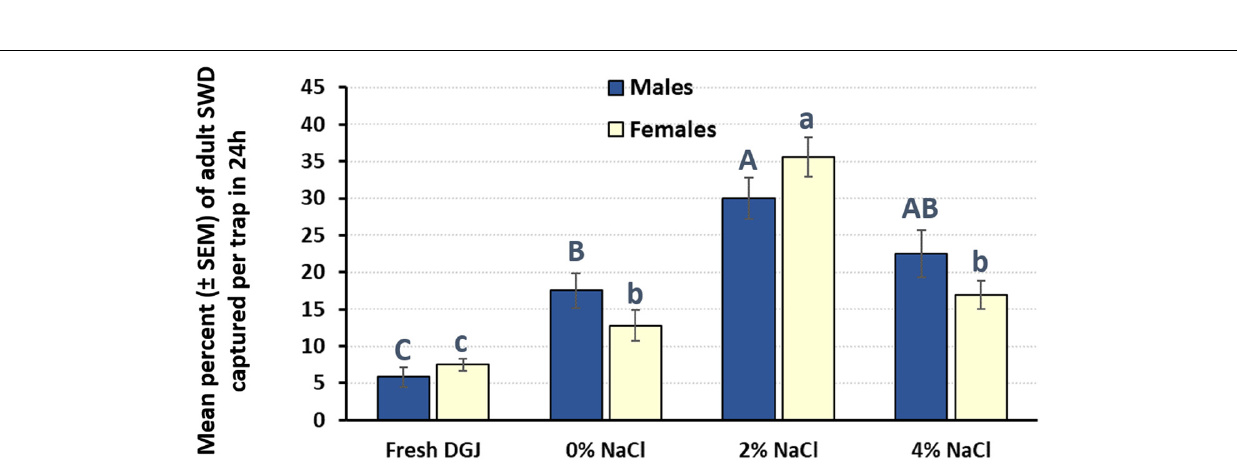
FIGURE 6 | Response, expressed as the percentage of male and female D. suzukii captured over a 24-h period in cages, to diluted grape juice either, fresh or aged for 7 days with 0, 2, and 4% of NaCl added prior to fermentation. For each fly gender, means superscribed by different letters indicate significant differences according to ANOVA and HSD Tukey tests at P =